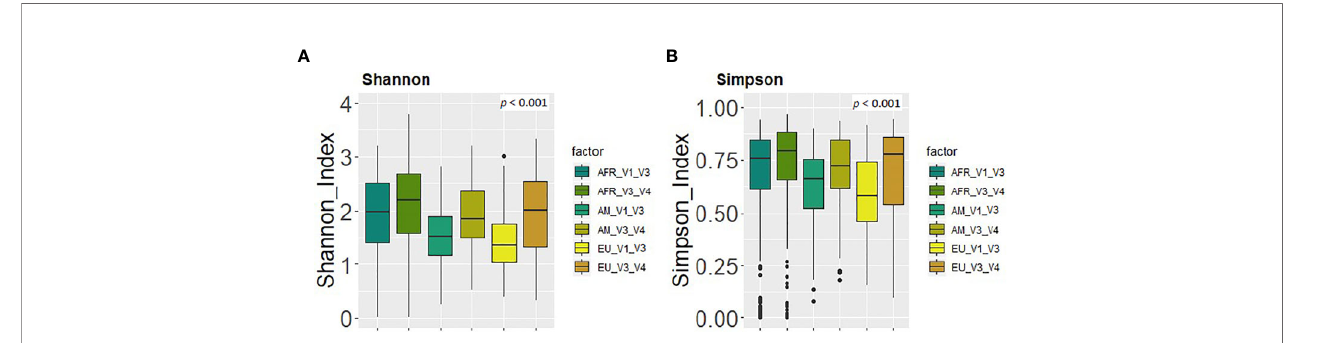
FIGURE 5 | Comparison between the values of alpha diversity obtained after the analysis at the genus level of the same set of milk samples, either with the V3-V4 (this work) or the V1-V3 (Lackey et al., 2019) approach and continent cohorts. (A) Shannon diversity index; (B) Simpson